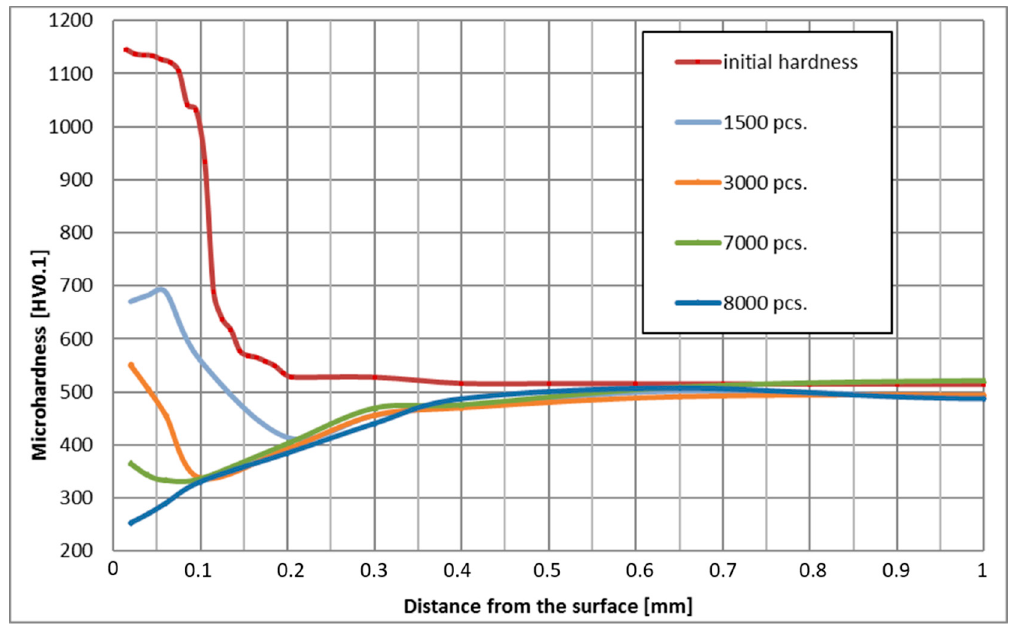
Figure 9. Results of microhardness measurement of nitrided surface layers after forging. Table 1. Working conditions of the forging die at different depths.